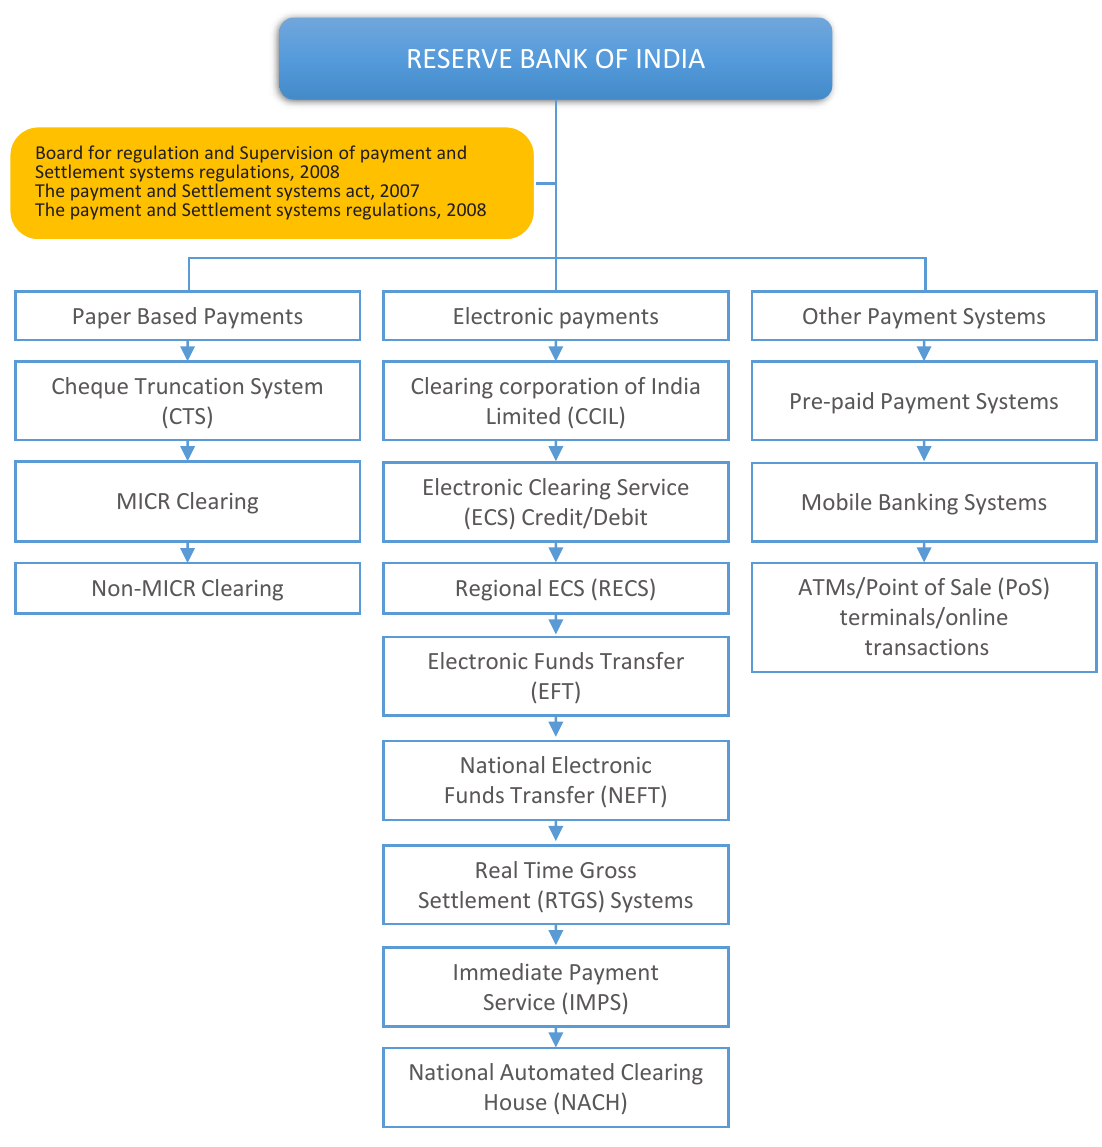
Figure 1. Payment system categories in